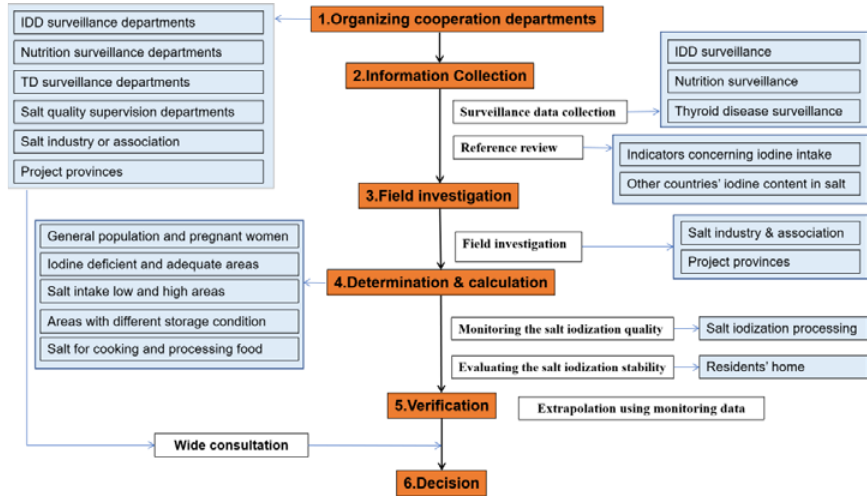
Figure 1. Procedure for selecting the iodine content in salt. IDD, iodine deficiency disorders; TD, thyroid disease.